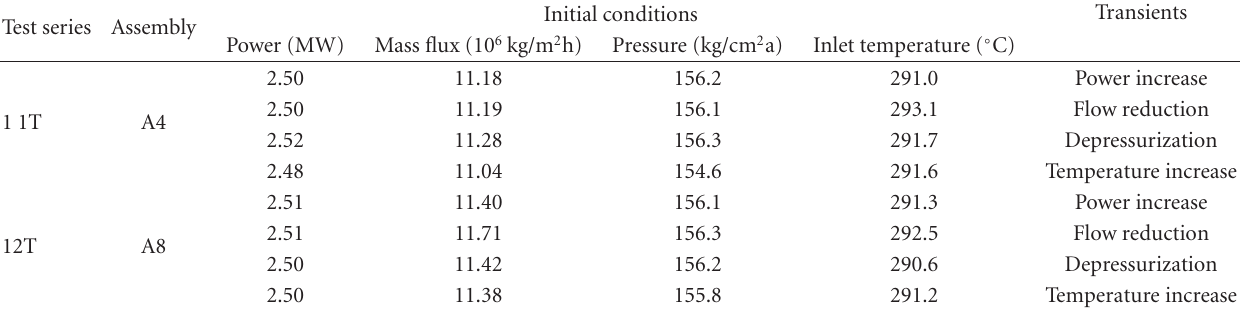
Table 10: Test series for transient DNB exercise